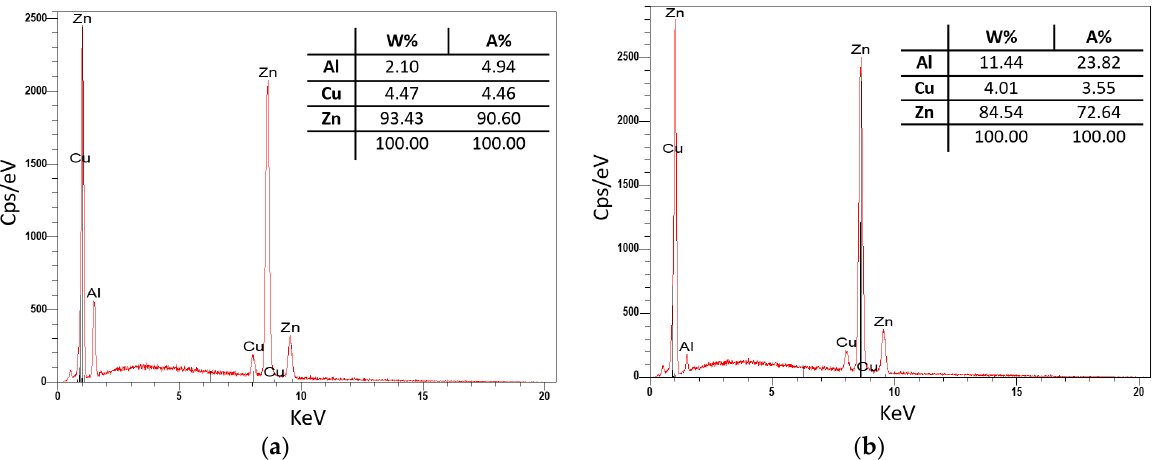
Figure 10. Quantitative analysis of P2: ( a ) dendrite-phase CuZn 4 and ( b ) eutectics-Al 4 Cu 3 Zn phase.